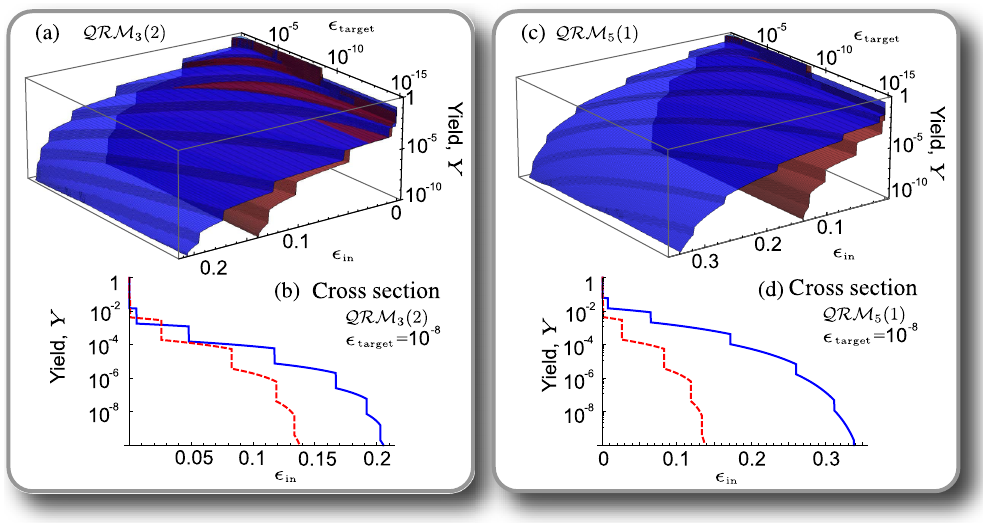
ð 2 Þ and QRM ð 1 Þ (blue), compared with the Bravyi-Kitaev QRM ð 4 Þ 3 5 2 and target error probabilities (cid:4) . For the qutrit and ququint in target